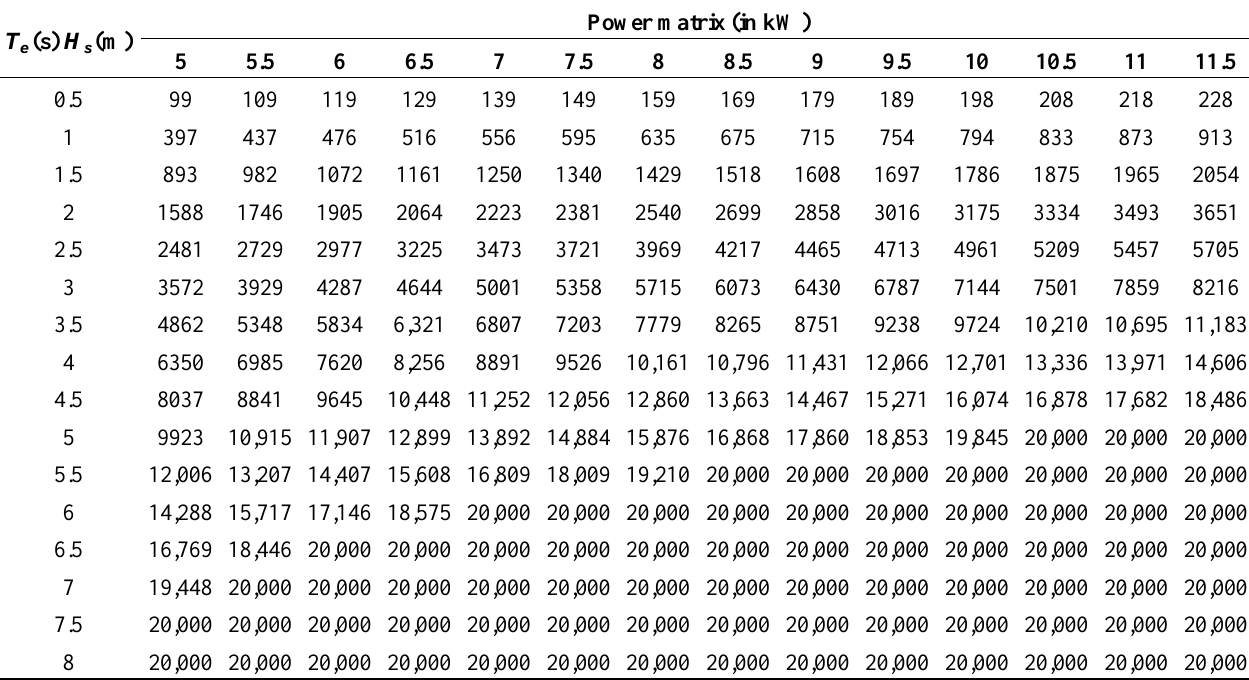
Table A5. Power matrix (in kW) for the Wave Energy Converter